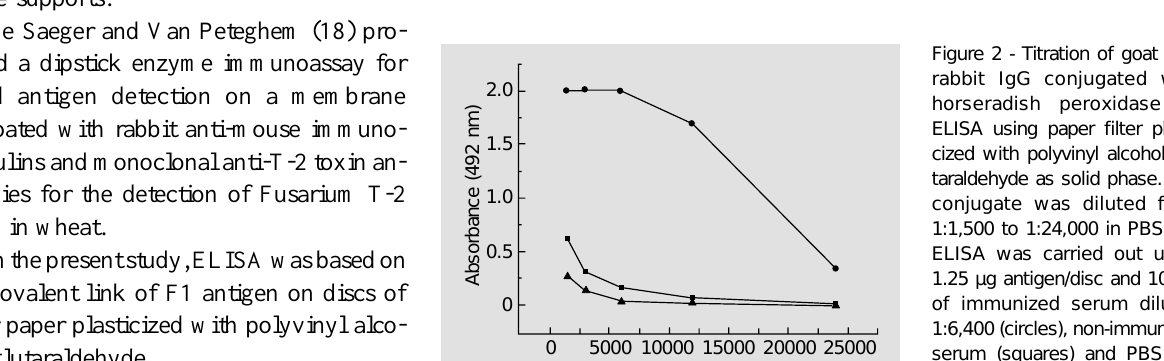
Figure 1 - Relationship between antigen immobilized (F1) on discs of filter paper plasticized with polyvinyl alcohol-glutaralde- hyde and ELISA results. Discs containing F1 antigen (100 µl) with protein concentrations ranging from 0.08 to 10 µg were incubated with 100 µl of immu- nized serum diluted 1:6,400 (circles), non-immunized serum (squares) and PBS (triangles). Goat anti-rabbit IgG conjugate (100 µl) diluted 12,000 times and substrate solution (100 µl), in- cluding OPD and H 2 O 2 , were used. The discs were removed and the absorbance of the su- pernatant at 492 nm was deter- mined with an ELISA reader.